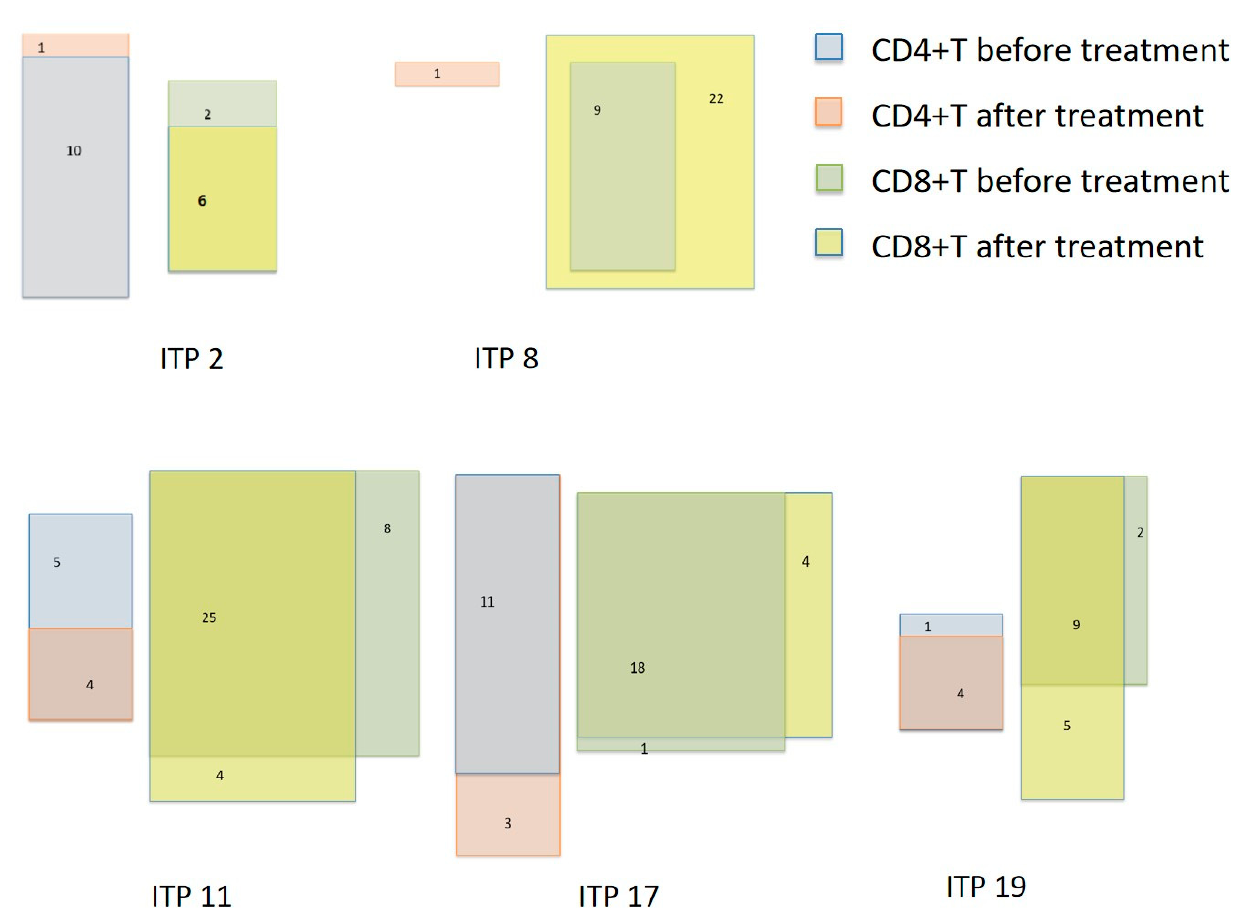
Figure 4. The diagram of CD4 + T and CD8 + T cells’ HECs comparison of patients. To clarify the diagram, ITP 2 was taken as an example: There were 10 CD4 + TCR HECs before treatment and eleven CD4 + TCR HECs after treatment. And the 10 CD4+ TCR HECs before treatment still existed as HECs after treatment. There were 8 CD8+ TCR HECs before treatment, and among them, 6 HECs existed after treatment. However, ITP 19 showed a little different alteration in CD8+ TCR HECs. Before treatment, there were 11 HECs. Among them, 9 HECs remained as HECs after treatment, while 2 HECs deminished. Another 5 new HECs emerged after treatment.